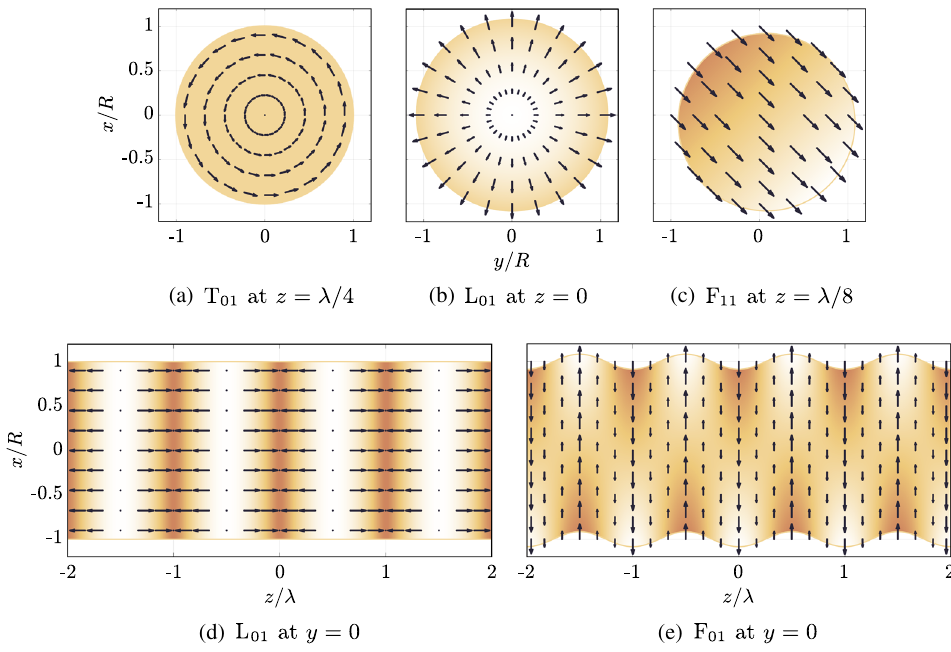
FIG. 6. Mechanical nanofiber eigenmodes on the three fundamental bands. Panels (a) – (c) show a cross section of the nanofiber, panels (d) and (e) a longitudinal section. The arrows correspond to the displacement field of a single mode with arbitrary amplitude β γ ; see Eq. (C8). The color gradients show density variations ∇ · u displayed at r þ u ð r Þ to simultaneously indicate the displacement of the fiber section. Darker areas are of higher density than lighter areas. Displacements in the vector plot are exaggerated by a factor of 2 compared to the density plot. The mechanical properties of the fiber are given in Appendix E. All three phonon modes have frequency ω ¼ 2 π × 123 kHz resonant with the radial atom trap; see Sec. III. The wavelengths λ ¼ 2 π =p are much larger than the nanofiber radius and vary between modes. The longitudinal sections therefore do not preserve the aspect ratio of the fiber: The z axis is compressed by a factor of λ =R ≃ 4 × 10 5 relative to the x axis for the L mode in (d) and by λ =R ≃ 2 × 10 3 for the F mode in (e), while both components of the displacement field are drawn to the same scale. The T 01 mode in (a) leads only to azimuthal displacement and does not induce density variations. The L 01 has a dominant longitudinal component resulting in density waves along = ð ω R ν Þ ≃ 1 . 8 × 10 5 . The the fiber axis; see (d). Its radial component causes breathing of the fiber radius and is smaller by a factor c h radial component in (b) is exaggerated by a corresponding factor compared to the axial component in (d) in order to be visible. The F 11 mode displaces the entire fiber cross section orthogonal to the fiber axis in a circular motion; see (c). The density variations in (c) and (e) result from longitudinal displacement that is smaller than the transverse displacement visible in the vector plot by a factor of